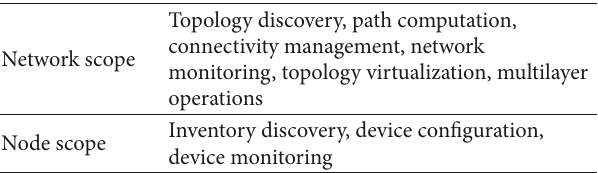
Table 1: Assignment of network management functions to